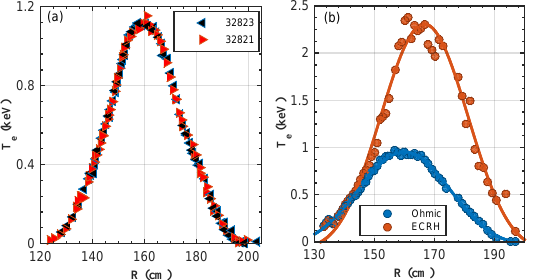
Figure 5. (a) Calibrated T e profiles obtained by shifting the mag- netic field in two similar discharges, and (b) T e profiles under ohmic and ECRH heating conditions.